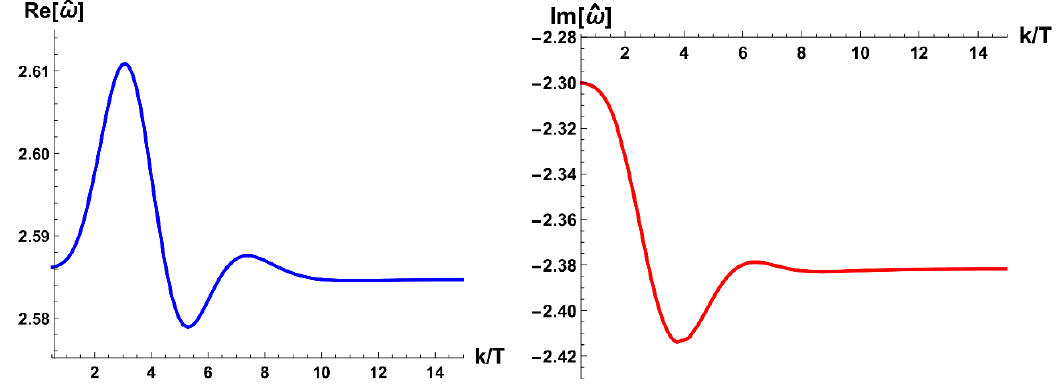
Figure 11 . Lowest non-hydrodynamic mode at zero spatial momentum in the shear/scalar channel at (cid:12)xed (cid:14) 2 =T 2 . We de(cid:12)ne ^ ! = != (2 (cid:25)T ) the reduced